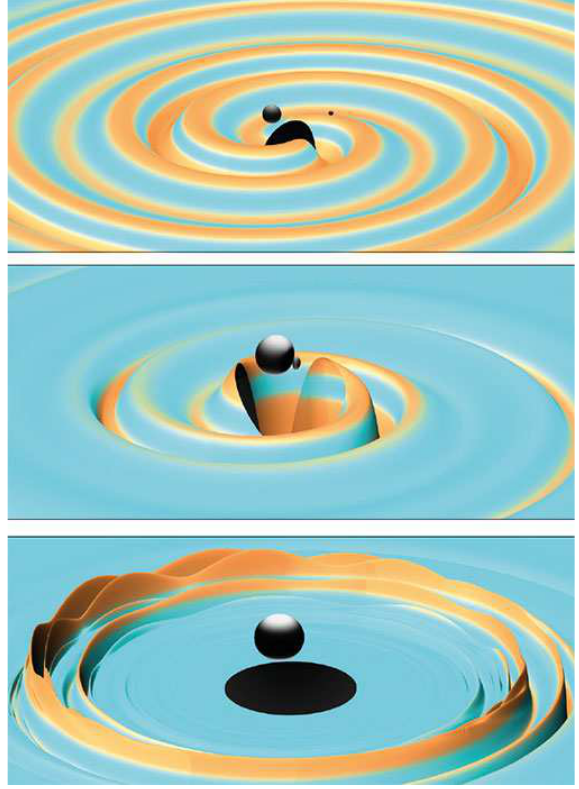
Figure 5. The three stages of binary black hole coalescence, namely the inspiral, merger and ringdown are depicted in this figure from top to bottom in the context of numerical relativity simulation of GW150914 carried out at Albert Einstein Institute, Germany. In the inspiral phase depicted in the top panel two black holes orbit around one another in a quasi-circular orbit which decays as the gravitational waves slowly drain the orbital energy. During the merger phase depicted in the middle panel two black holes bang into each other at the relativistic speeds and form a single black hole. A burst of gravitational waves with extremely large luminosity is given out during the merger phase. During the ringdown phase depicted in the lower panel, the remnant black hole which is in the excited phase sheds out the deformation away from the Kerr configuration by emitting gravitational waves. (Image credit: